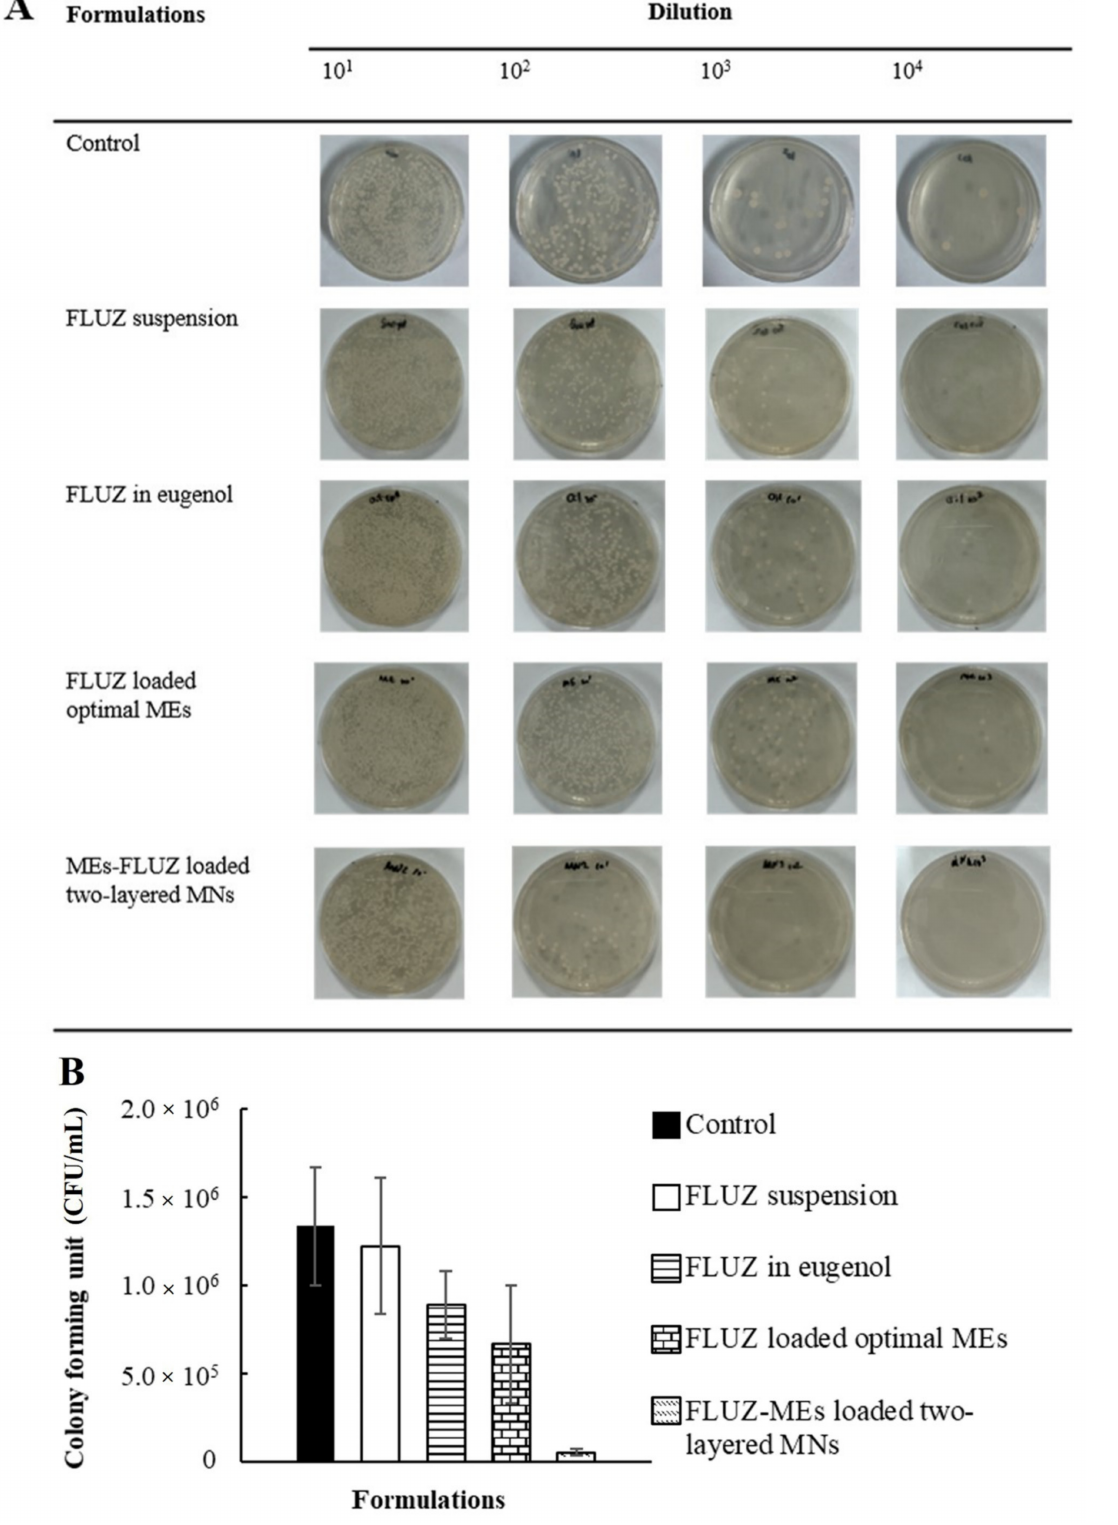
Figure 11. Ex vivo antifungal activity in excised porcine corneal tissues. ( A ) C. albicans colonies formed after 24 h of diluted corneal homogenate on SBA plate with different FLUZ formulations. ( B ) Colony-forming units after 24 h with different FLUZ formulations. Each formulation is represen- tative of triplicate trials. * indicates a significant difference than other formulations ( p <